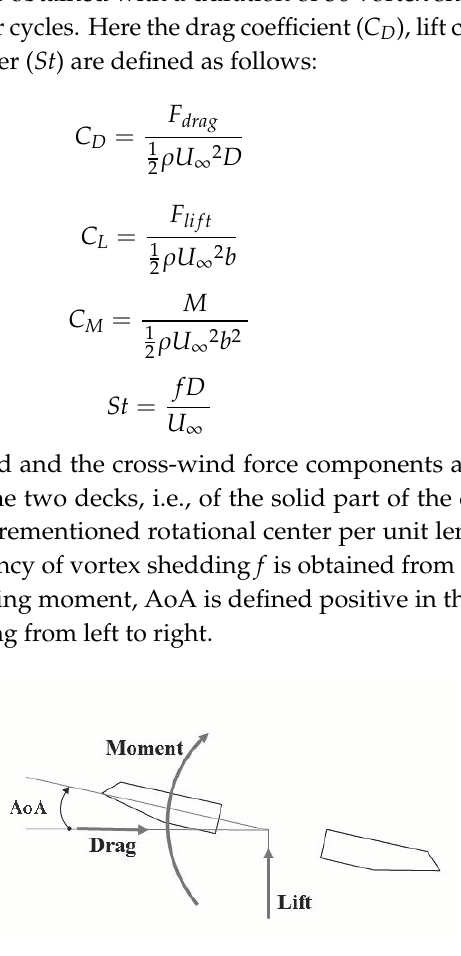
Figure 3. Sign convention.